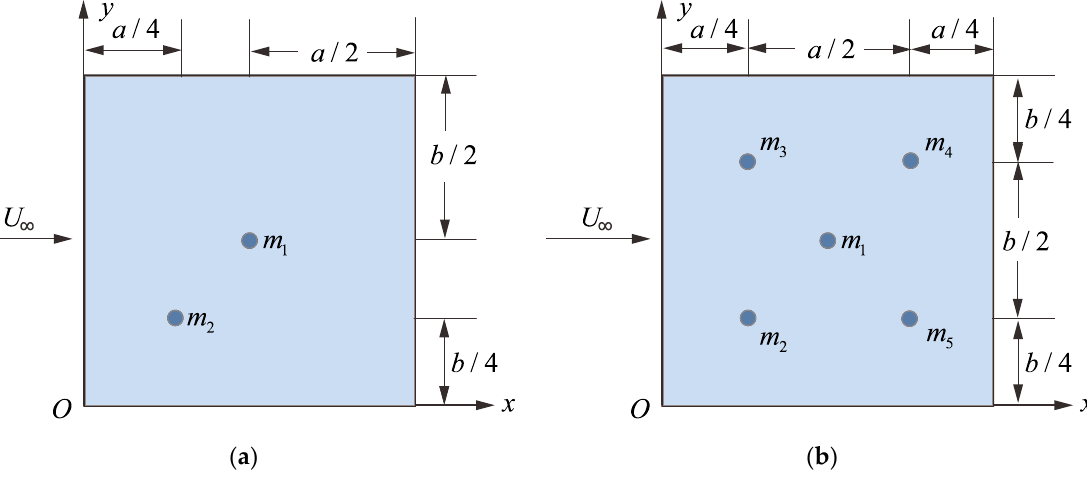
Figure 11. Two position relations of the panel with two or more mass attachments: ( a ) one point located at CP and the other at QP (TP); ( b ) there are 5 mass attachments on the panel (MP).